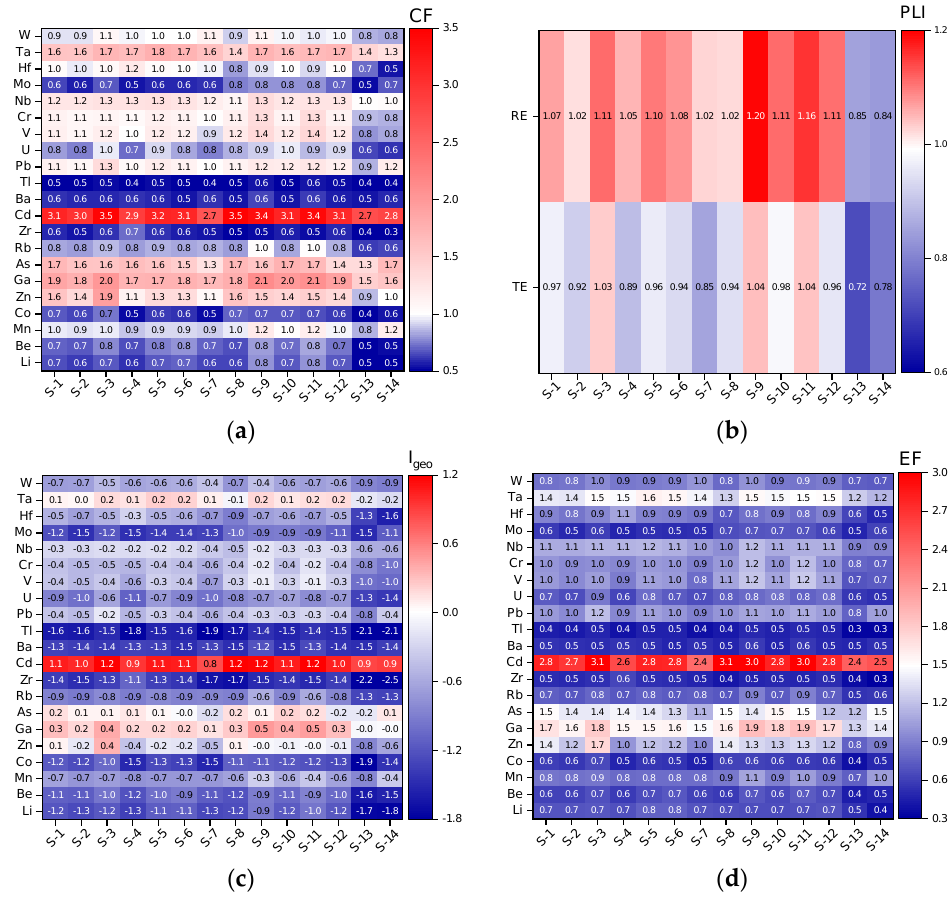
Figure 7. Contamination factors (CFs), ( a ) pollution load indices (PLIs), ( b ) geoaccumulation indices (I geo s) ( c ), and enrichment factors (EFs) ( d ) calculated for the sediment sampling points from Podu Iloaiei Lake.